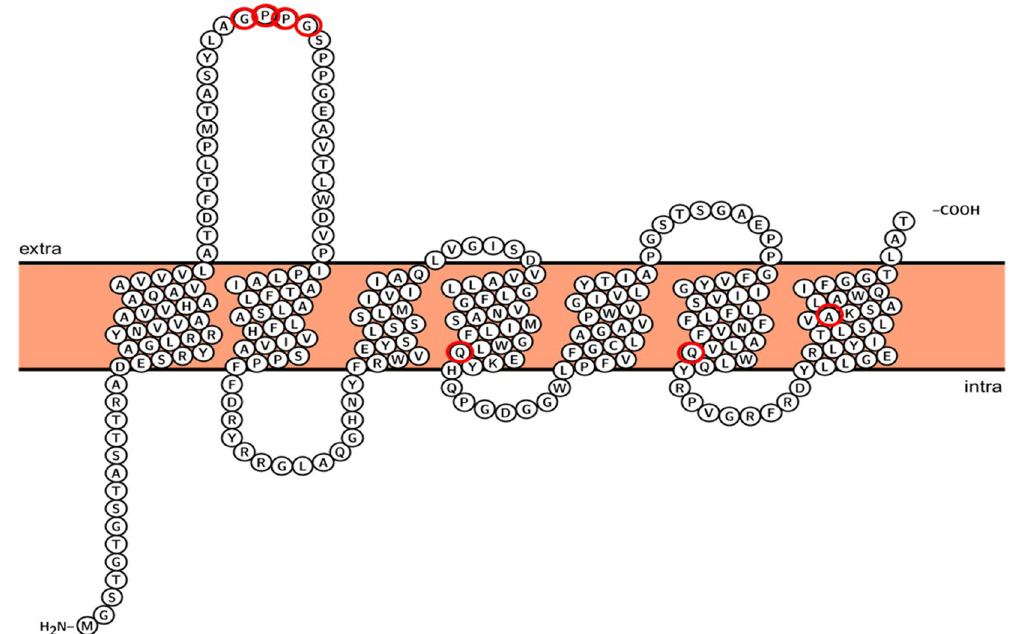
Figure 3. Candidates for the residues involved in the color-tuning of natural variants of heliorhodopsins. The topology prediction of Ornithinimicrobium heliorhodopsin (λmax = 556 nm) obtained with Protter. Red open circles are candidate amino acids for the spectral tuning site. The comparison is the sequence from Fig. 2 (G59 ~ G62, Q159M, Q224M, and A254S of Ornithinimicrobium heliorhodopsin) and Thermococcus sp. 2,319 ×